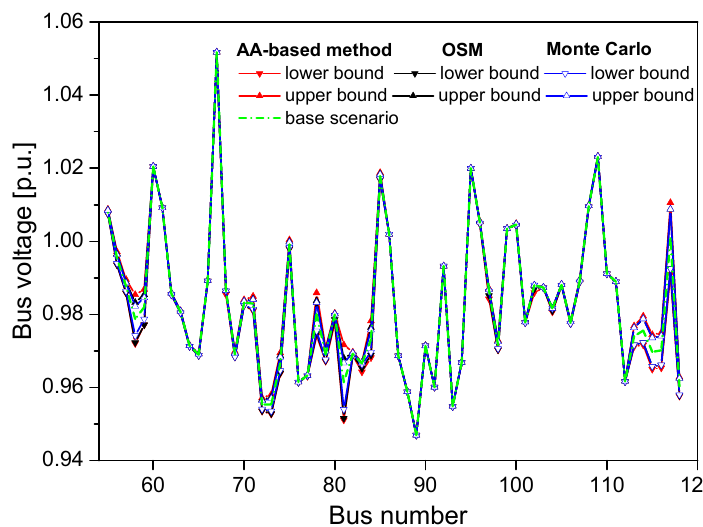
Figure 13. Load voltage magnitude results obtained by different methods.